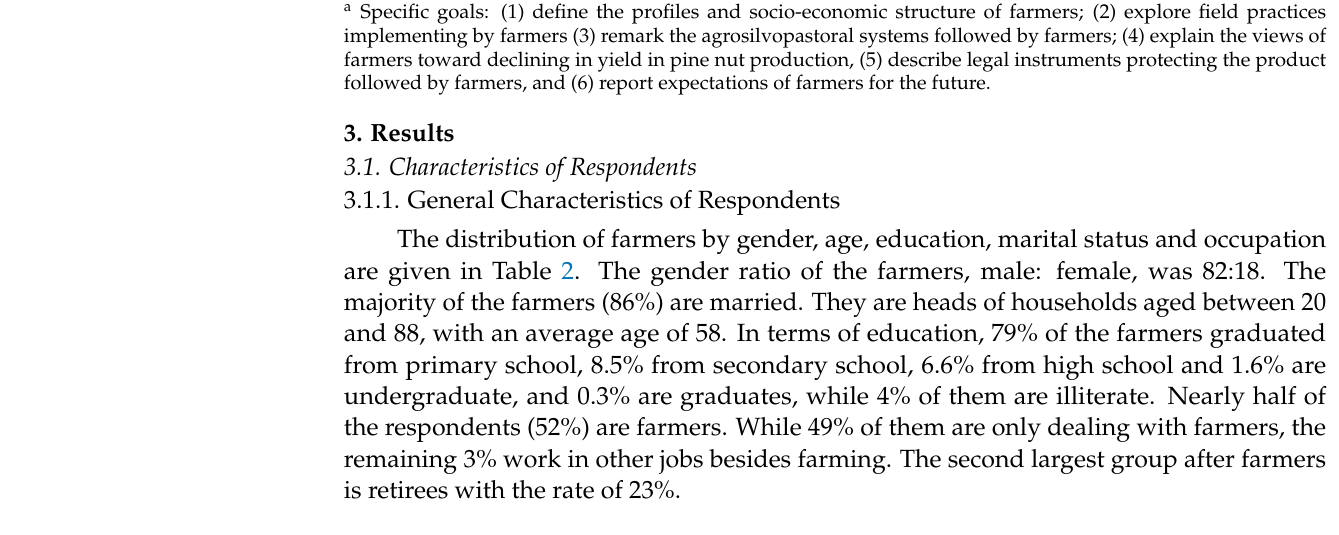
Table 2. General respondent characteristics (n =